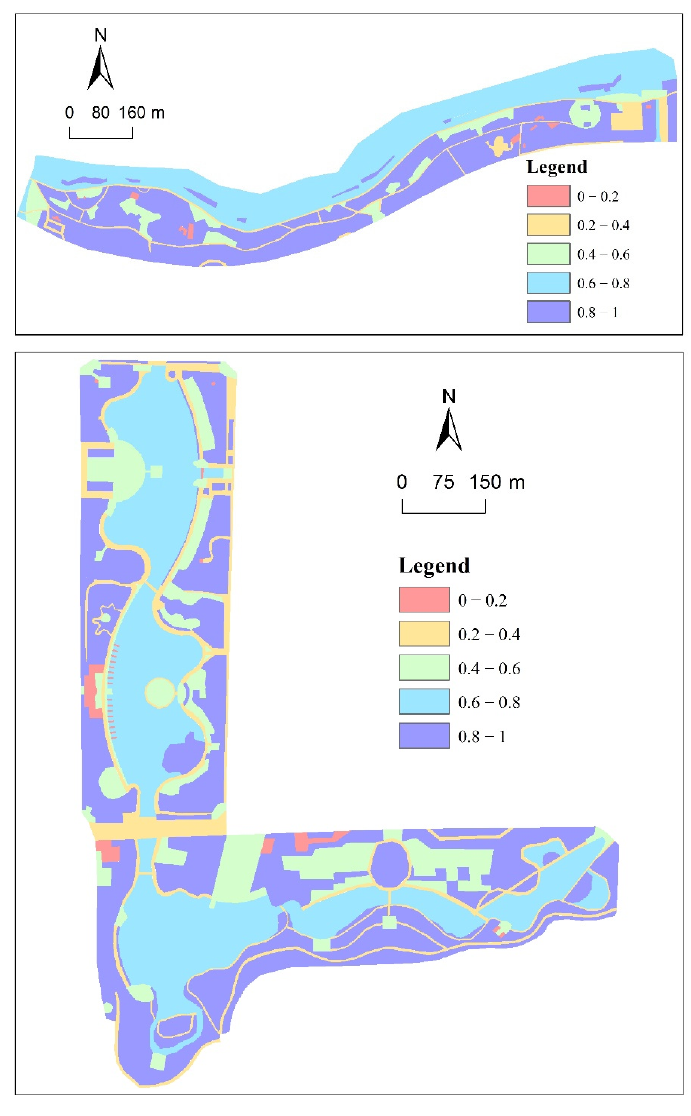
Figure 4. Habitat quality of Foshan New Town Riverside Park and Foshan Qiandeng Lake Table 2. Descriptive statistics of waterfront characteristics.